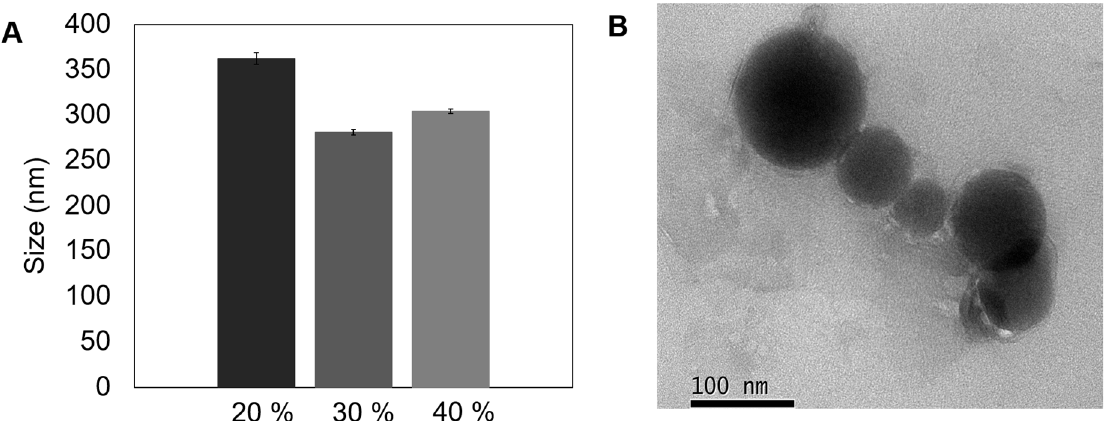
Figure 3. Morphological characterization and particle size of polyacrylic acid/ Schizochytrium sp. (PAA/Schizo) microgels obtained by inverse emulsion assisted by ultrasound. ( A ) Size of synthe- sized microgels at different amplitudes. ( B ) Transmission electron microscopy (TEM) image of microgels syntesized at 30% amplitude for 20 min. Data shown is the mean of three independent measurements ± standard deviation (SD).